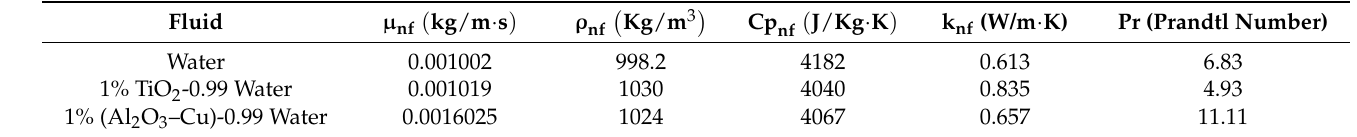
Table 1. Thermo-physical properties of the fluid used in the analysis [27–29].